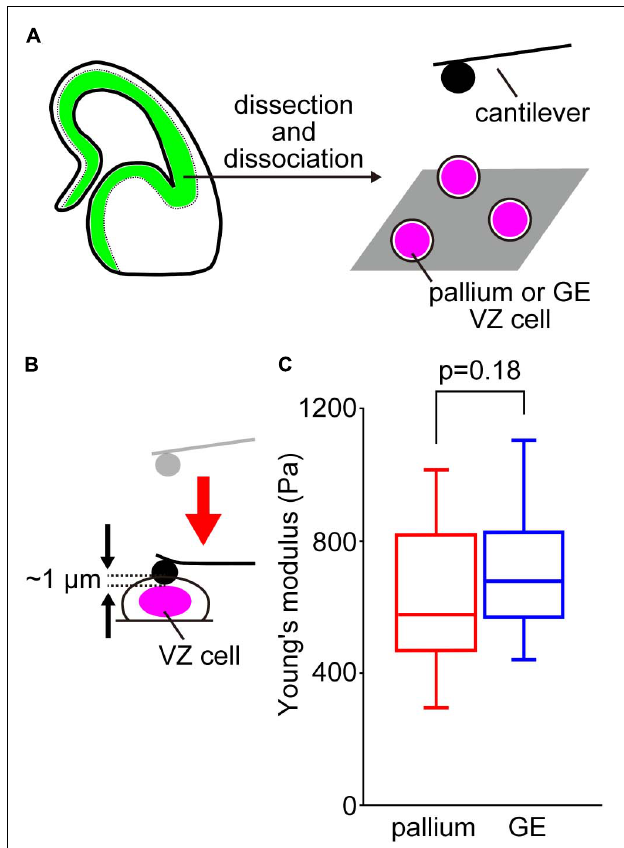
FIGURE 3 | AFM measurements of cells dissociated from the VZ of the pallium and the GE. (A) Experimental design. (B) Illustration showing AFM indentation measurement of dissociated VZ cells. (C) Graph showing the Young’s moduli of pallial VZ cells ( n = 50 cells) and GE VZ cells ( n = 52 cells) ( p = 0.18, Mann–Whitney U